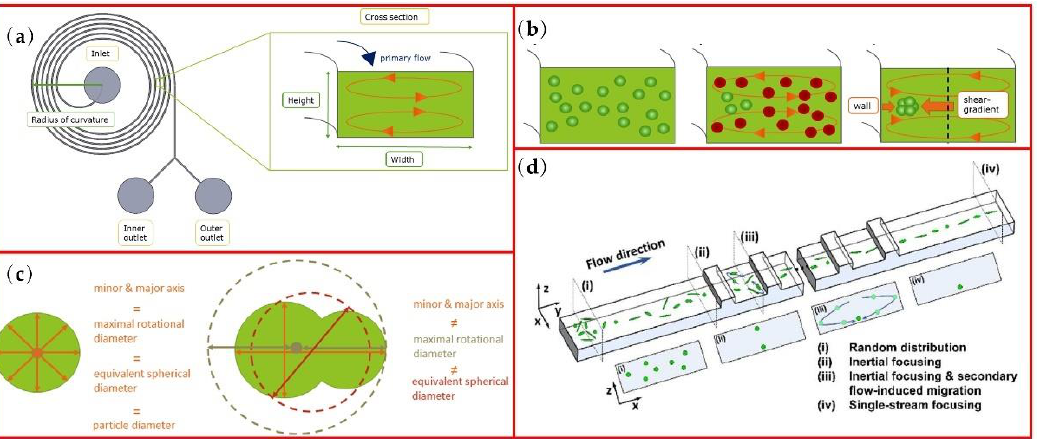
Figure 5. Non-spherical particles focusing in spiral microchannels: ( a ) Dean flow in the cross section of a spiral microchannel; ( b ) focusing of unstable particles (red) to stable positions (green); ( c ) dimension parameters for spherical and non-spherical particles. Another secondary microchannel of ( d ) ellipsoid-shaped E. gracilis focusing with different aspect ratios in a stepped microchannel. Figures ( a – c ) are reprinted with permission from [33], Copyright 2018 AIP publishing. Figure ( d ) is reprinted from [87], Copyright 2016 RSC publishing.